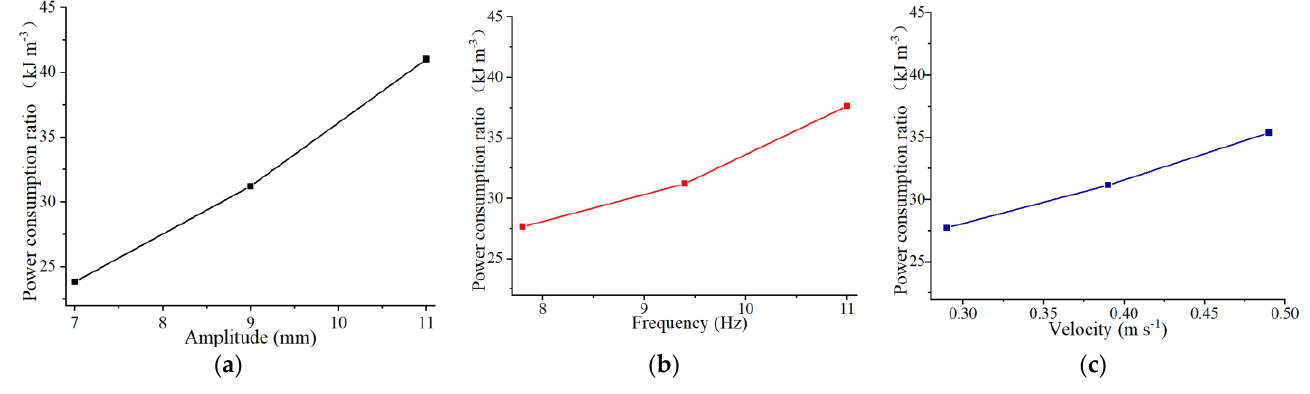
Figure 12. Effect of each parameter on the comparison of power consumption: ( a ) Amplitude; ( b ) Vibration frequency; ( c ) Forward speed.